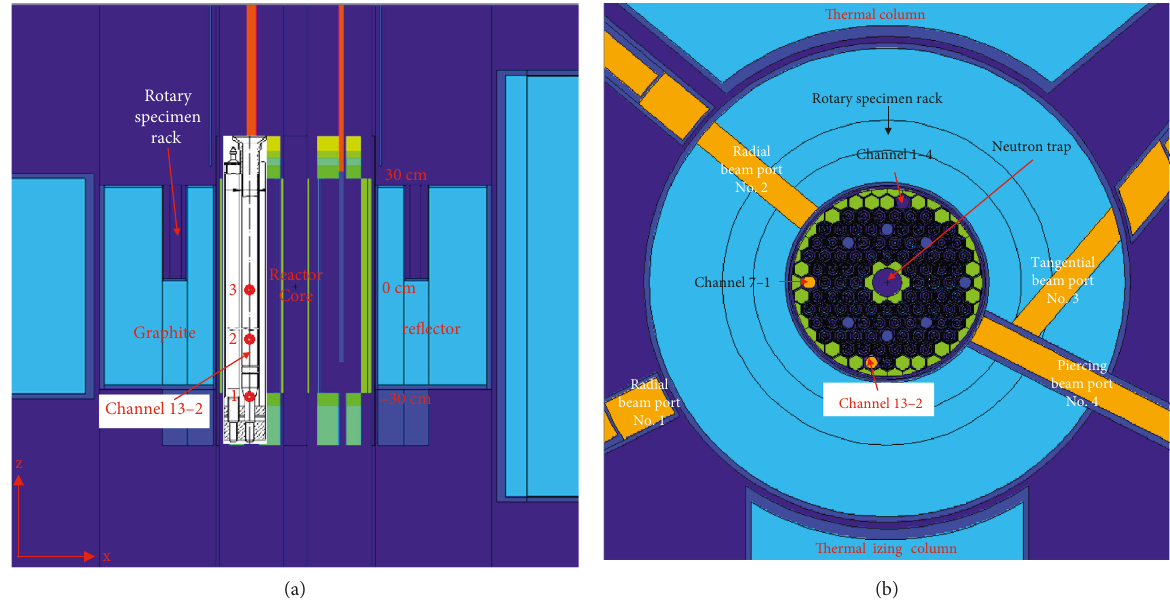
Figure 4: Vertical (a) and horizontal (b) cross sections of the reactor core and graphite reflector. Table 2: Thermal neutron flux in the vertical and horizontal irradiation channels of the reactor. Thermal neutron flux (n/cm 2 Irradiation channel